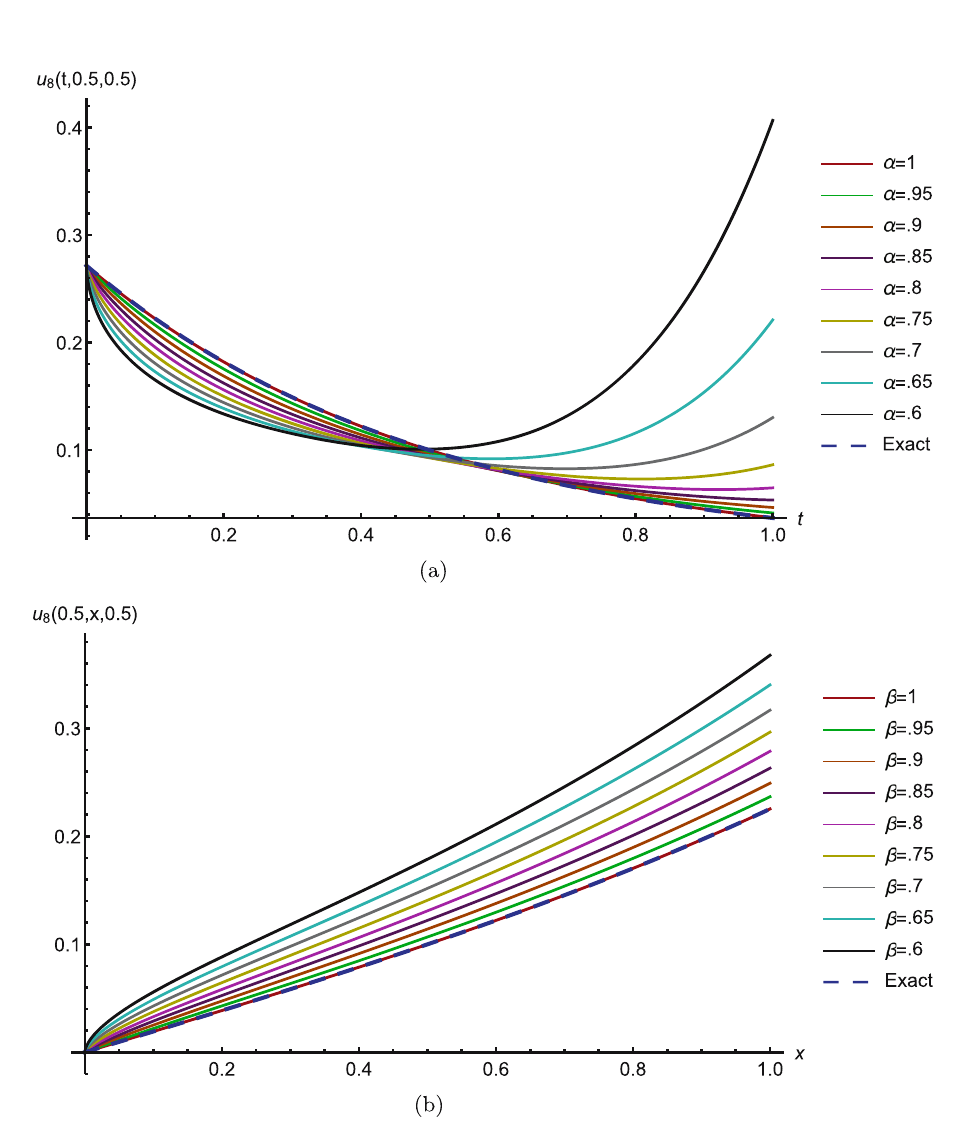
Figure 2: The cross - section behavior of u t x y , , 8 ( ) for ( 3.22 ) at various values of α β γ , , ∈ ( 0,1 ) . ( a ) β γ 1 = = . ( b ) α γ 1 = =